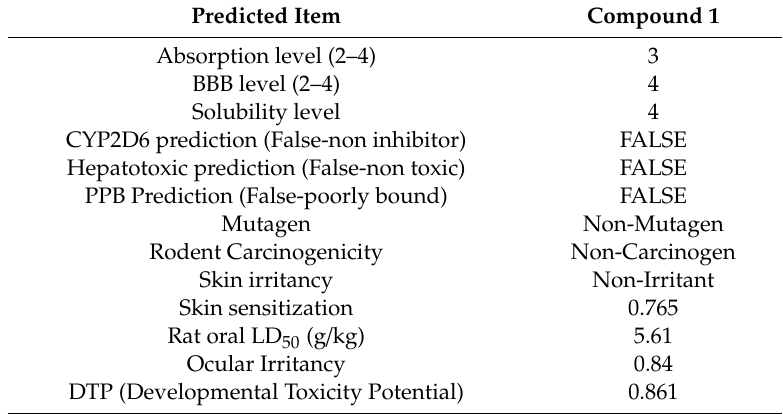
Table1. Absorption, distribution, metabolism, excretion, andtoxicity(ADMET)andTOPKATprediction of steviophethanoside.